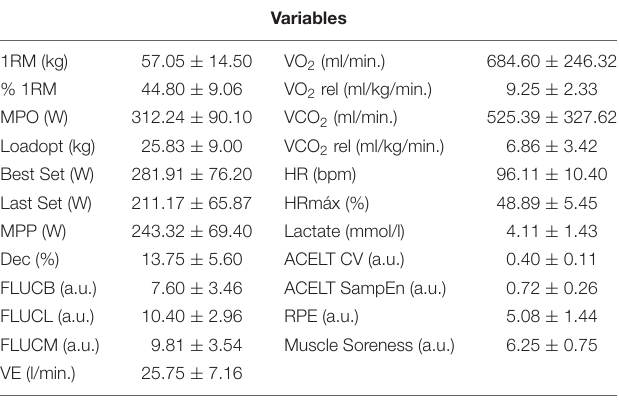
TABLE 2 | Overall results from the Bench-Press RPA